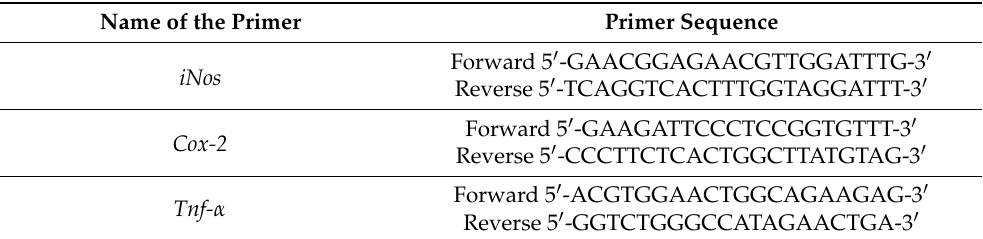
Table 1. Primers used in the quantitative reverse transcription polymerase chain